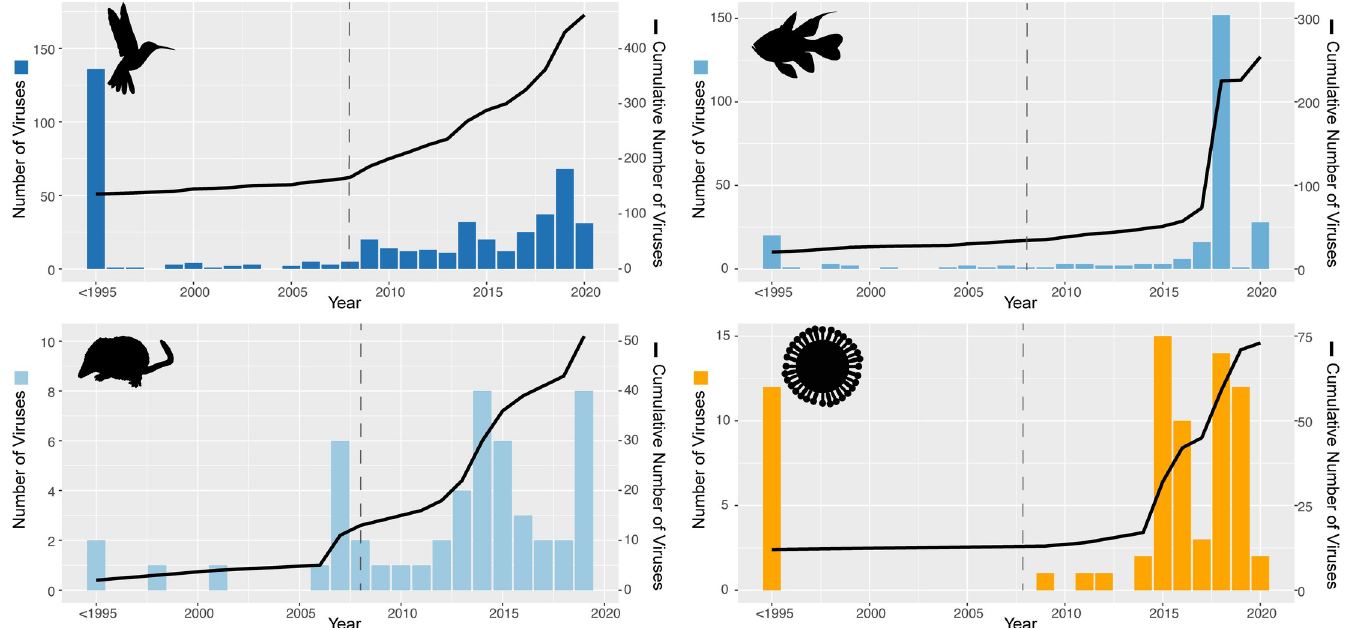
Fig 2. Recent increases in documented virus discovery. Bars indicate the number of new viruses described per year. Line represents the cumulative number of viruses described. All viruses described before 1995 have been presented as a single bar and thus the year is indicated as “ < 1995.” The dashed line indicates 2008, the year the Jones and colleagues paper [1] was published, and our cutoff for Fig 1. Animal silhouettes are from phylopic.org and distributed under a creative commons attribution. The virus silhouette was generated by M. Wille. The source code and underlying data for this figure can be found at https://github.com/jemmageoghegan/Assessing-